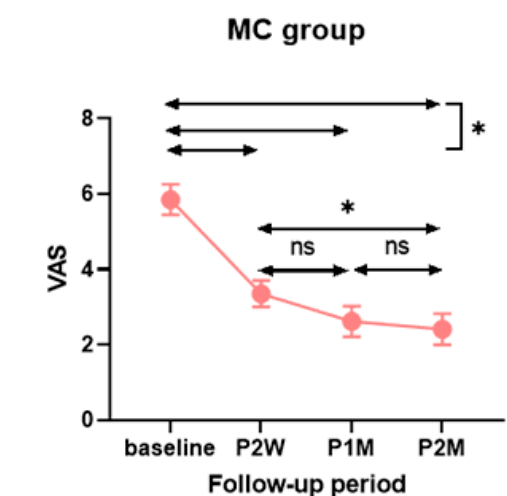
Figure 2. Comparison of subjective improvement of itching sensation over time between the two groups. ( A ) Change of visual analogue scale in the CI group. ( B ) Change of visual analogue scale in the MC group. CI, topical calcineurin inhibitor; MC, moisturizing cream; VAS, visual analog scale; P2W, post-treatment 2 weeks; P1M, post-treatment 1 month; P2M, post-treatment 2 months; *, statistically significant ( p < 0.05); ns, not significant.